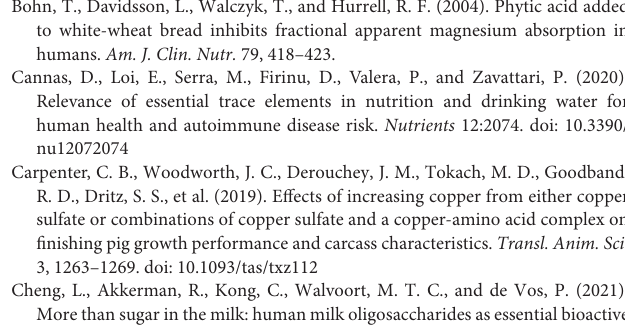
Supplementary Figure 1 | Application of four phytic acid-degrading bacteria in psm. Application of four acid-degrading bacteria in modified MRS plate. Supplementary Figure 2 | The microscope micrographs of psm16 strain. Supplementary Figure 3 | The pH values detection of the cecum contents in mice. Samples were centrifuged at 4 ◦ C for 8000 rpm for 1 min, and the further 0.8 µ L of the supernatant tested with pH indicator paper (pH 5–9) and the color change was